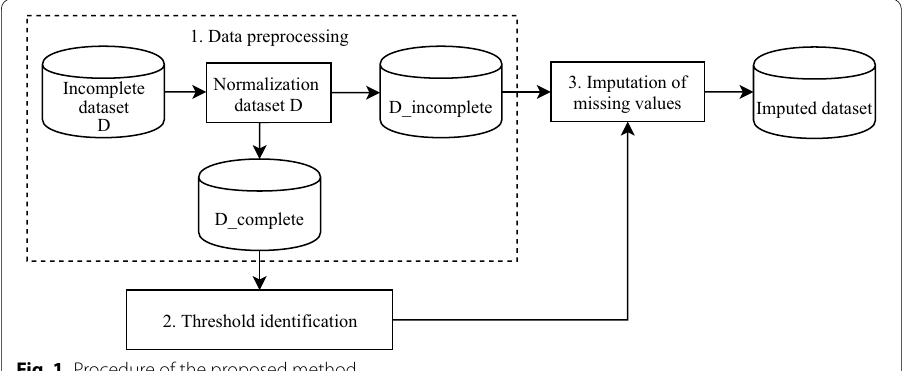
Fig. 1 Procedure of the proposed